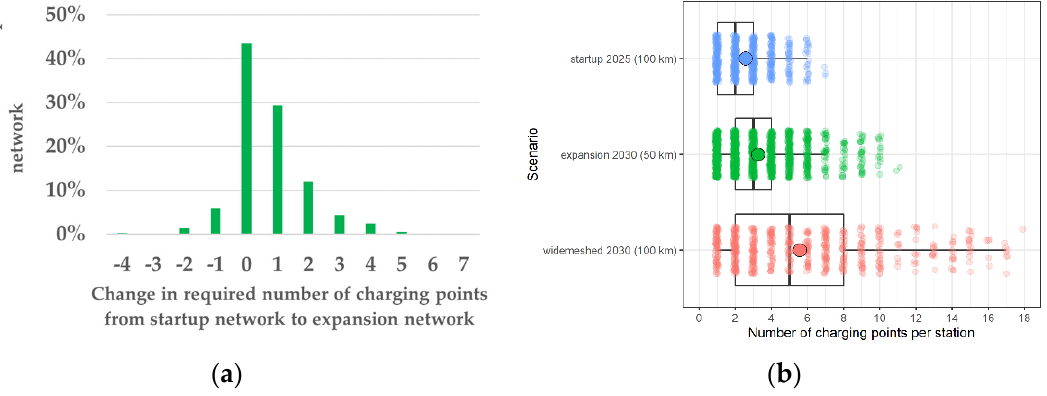
Figure 5. ( a ) Change in number of charging points from startup network to expansion network. ( b ) Boxplot of charging points per location for all scenarios.